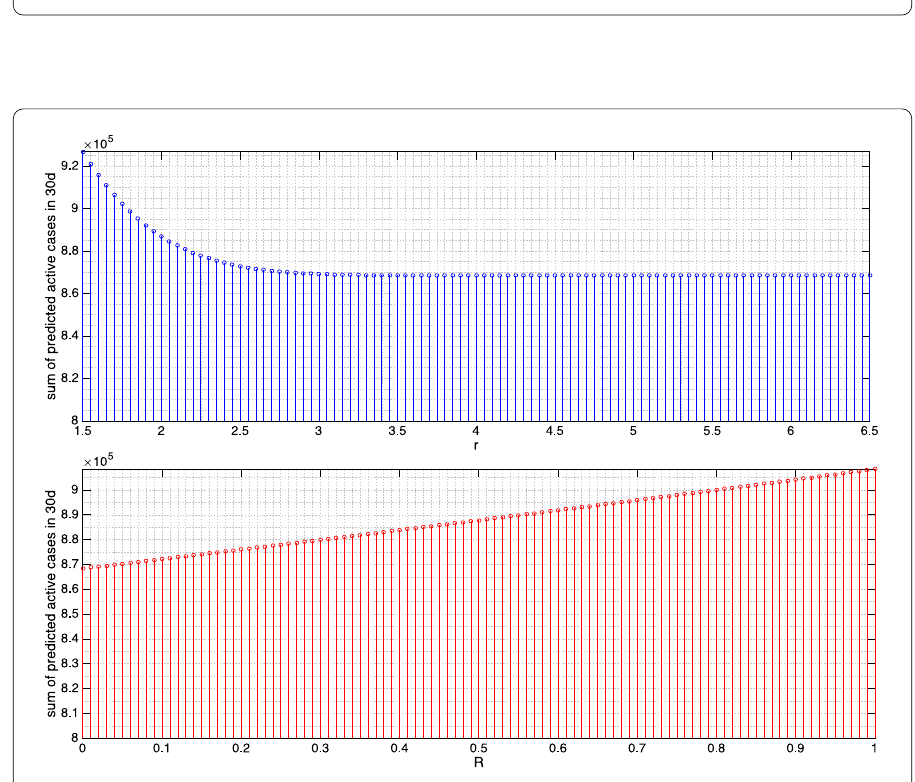
Figure 5 For the next 30d (April 12–May 11, 2020) in Germany, r = 3 leads to the reduction to 95.59%, R ≈ 1/4,1/3,1/2,3/4 to 96.65%, 96.99%, 97.73%, and 98.85%,